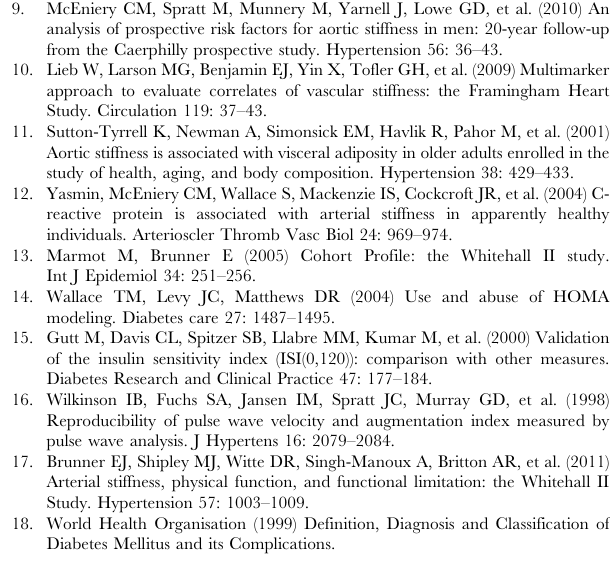
Figure S1 Standardized cross-sectional regression coef- ficients for association with aortic pulse wave velocity. (DOC) Methods S1 Detailed information on baseline measure- ments. Table S1 The fraction of the study participants with no information on the baseline determinant. Table S2 Difference (95%-CI) in aortic pulse wave velocity at follow-up by a unit difference in determinants at follow-up. Table S3 Baseline characteristics by follow-up partici- pation and aortic pulse wave velocity measurement for those alive at